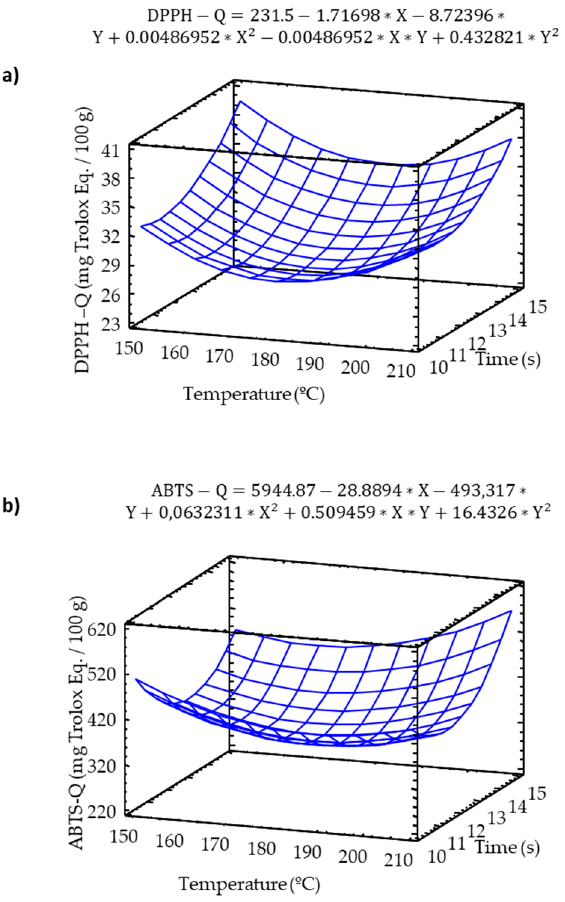
ff ect of temperature and time on ( a ) DPPH-Q, ( b ) Figure 5. Response surface model of the effect of temperature and time on ( a ) DPPH-Q, ( b ) ABTS-Q. Figure 5. Response surface model of the e